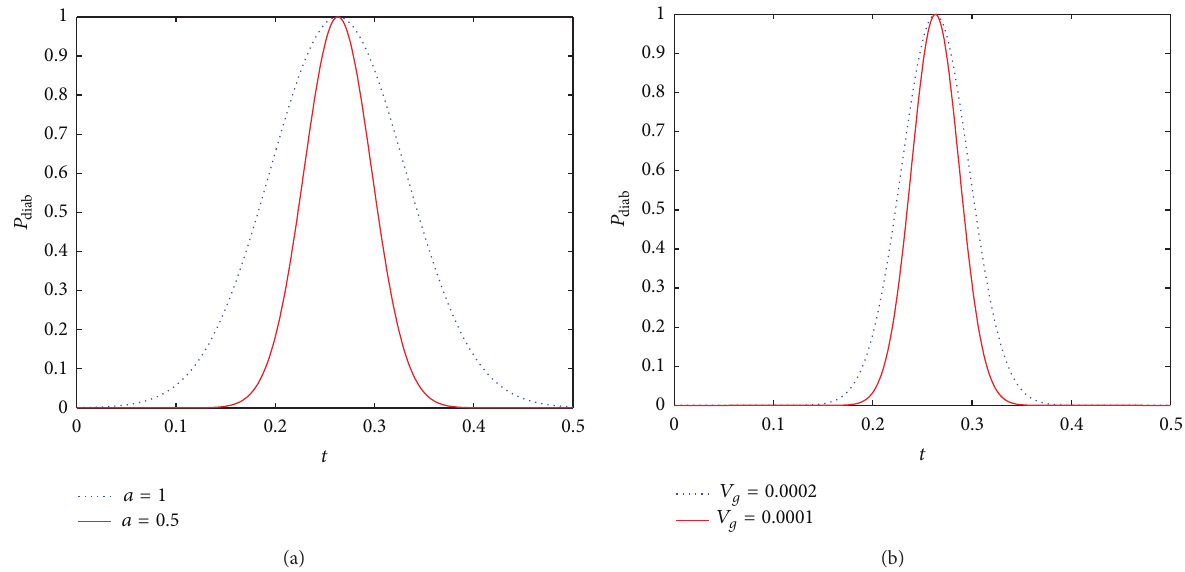
Figure 5: Plots of the LZ transition probability versus time, in the sudden limit expressed in (12). The curves inserted in Figure 5(a) show the behavior for different values of the noise amplitude 𝑎 and in Figure 5(b) for different values the group velocity.